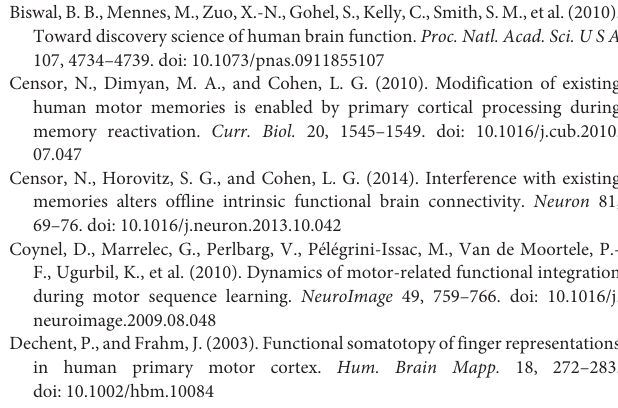
SUPPLEMENTARY FIGURE 1 | Group-level activation map for performing sequential finger-tapping task with left hand averaged across pre- and post-scanning sessions and both sequences (voxel-wise p < 0.005 corrected, cluster-level p < 0.01 corrected; the MNI coordinates of the peak voxel: x = 40 , y = − 24 , z = 60 ). The z -values represent activation intensity. L: left; R: right. SUPPLEMENTARY FIGURE 2 | FC maps of an exemplar participant in the post-training scanning session for each condition before and after the corresponding baseline period FC maps are subtracted. The z -values are the result of the Fisher’s transform of the Pearson’s correlation coefficients that measured functional connectivity strength. SUPPLEMENTARY FIGURE 3 | Changes in connectivity pattern stability (after vs. before training) for trained and untrained sequences corresponding to event-related epochs of 7 ( a ) and 9 TRs ( b ). Error bars denote S.E.M. * p < 0.05, ** p < <0.01. SUPPLEMENTARY FIGURE 4 | Correlation between the learning index (LI) of performance speed and that of connectivity pattern stability across participants. Performance speed was calculated as the number of correctly completed sequences in 30 s. Learning index for both performance speed and FC pattern stability was calculated as follows: (trained_post – trained_pre) – (untrained_post –